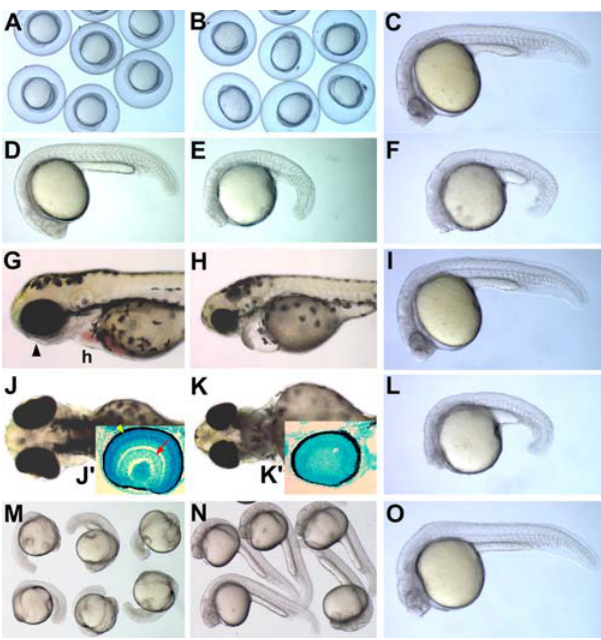
Figure 3. Mych morphant phenotypes. A–B. Group image of 3- somite stages. Mych MO-injected embryos (B) have reduced anterior and caudal regions compared to control MO-injected embryos (A). C–F. Lateral view of 24hpf MO-injected embryos; (C,D) Control, (E) mych UTR MO, (F) mych SP MO. G–H, J–K. Lateral (G–H) and ventral (J–K) views of control (G,J) and mych UTR MO injected embryos (H,K) at 72hpf. Arrowhead in G points to the eye. Methyl green stained sections of the eye are shown as insets (J’,K’).Yellow arrowhead in J’ indicates ganglion cell layer, and red arrow indicates photoreceptor cell layer of control embryos; mych UTR MO-injected embryos show no retinal layering. F,I. Lateral view of 24hpf mych SP MO injected embryo (F), and embryo rescued by coinjection of mych mRNA (I). L,O. Embryo injected with mych UTR MO (2ng) plus mych SP MO (2.5ng) at 24hpf (L), and rescued embryo after coinjection of mych mRNA (O). M–N. The phenotype of